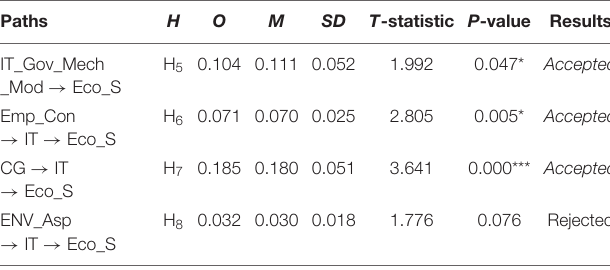
TABLE 7 | The indirect effects of the variable. Paths H O M SD T -statistic P -value Results IT_Gov_Mech H 5 0.104 0.111 _Mod → Eco_S